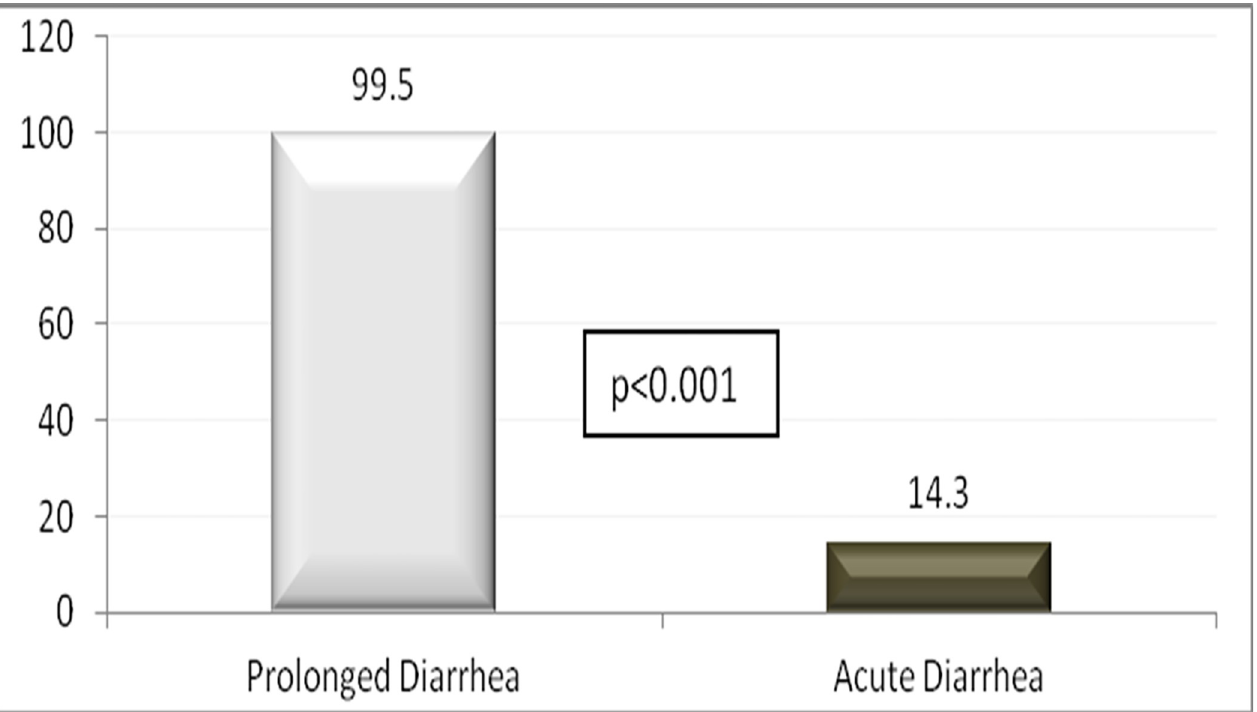
Fig 3. Percent of children with prolonged diarrhea and acute diarrhea required hospital stay for > 3 days.